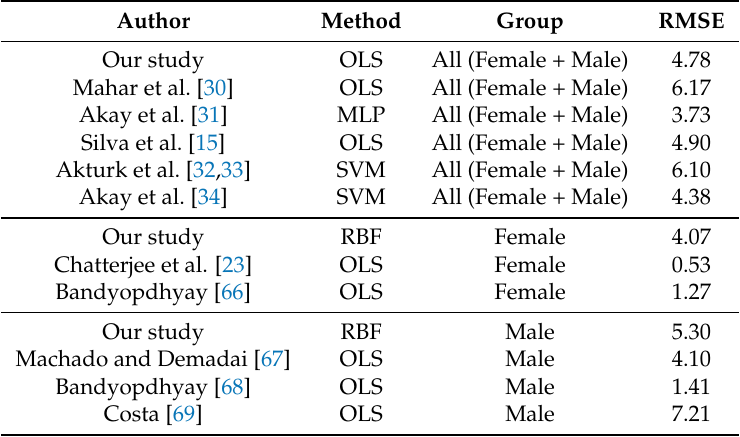
Table 6. Comparison of predictive